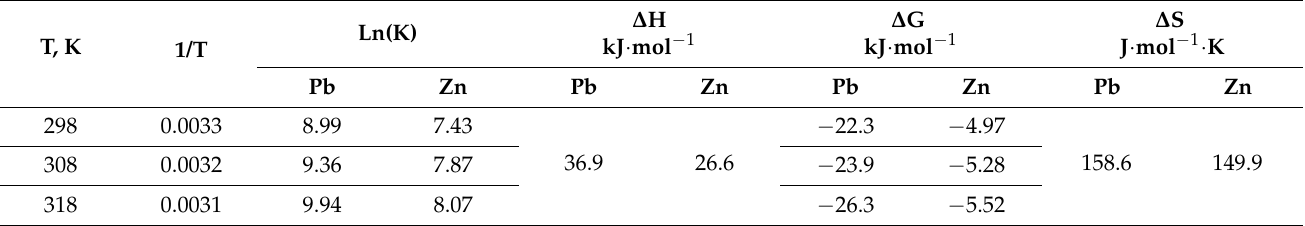
Table 6. Thermodynamic parameters of lead and zinc ions in the adsorption